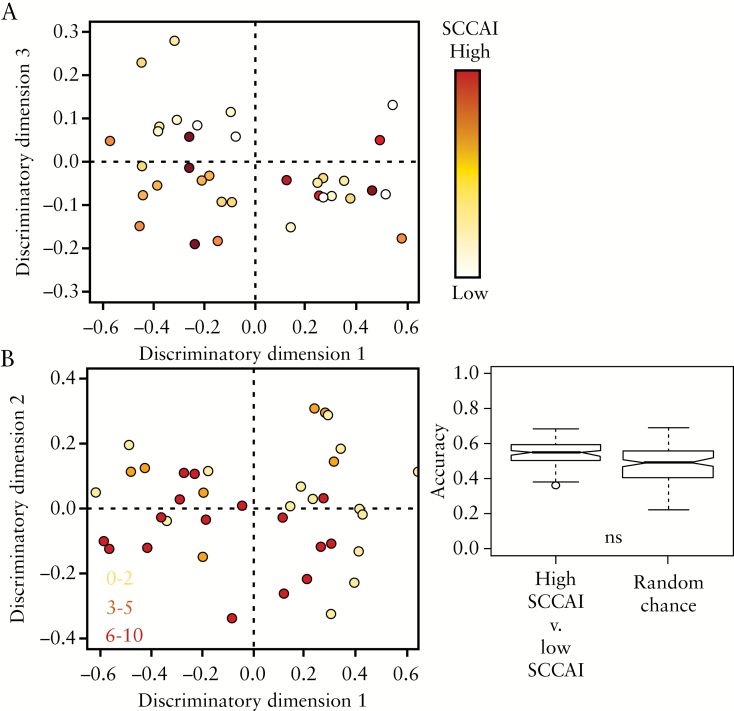
[A] PCA scores plot representing the distribution of SCAII scores within the cohort. In contrast to the UCEIS, no spontaneous clustering as a result of SCAII is observed. [B] OPLS-DA scores plot is unable to discriminate between the plasma NMR metabolite profiles based on SCAII. The accuracy of the OPLS-DA models is not significantly better than random chance.